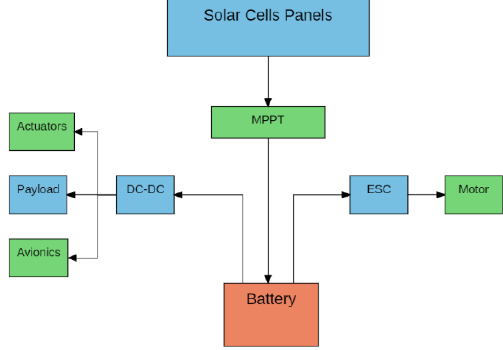
Figure 3. Basic electrical system of a Solar UAV.